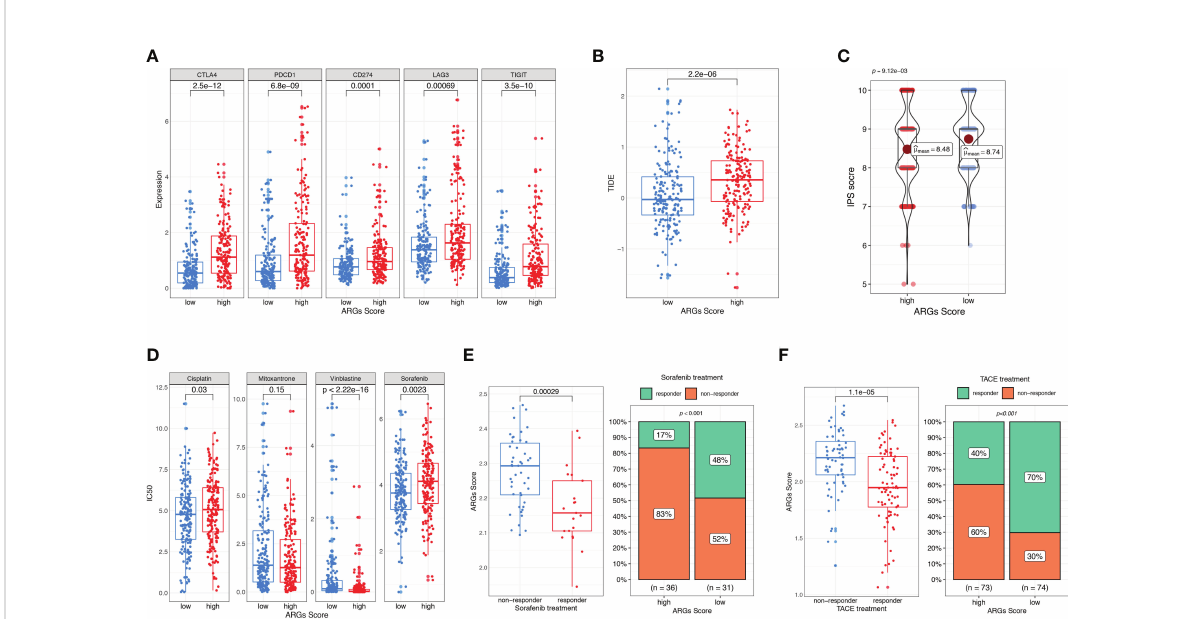
FIGURE 10 Evaluation of therapeutic response and drug sensitivity based on the ARGs Scoring model. (A) The correlation between ARGs Score and immune checkpoints genes. Difference in TIDE (B) and IPS (C) between the high-score and low-score groups. (D) Drug sensitivity analysis. IC50 of different drugs were compared between high-score and low-score groups. (E) Comparison of ARGs Score between sorafenib responder and non-responder. The fraction of sorafenib responder between subgroups based on ARGs Score classi fi er. (F) Comparison of ARGs Score between TACE responder and non-responder. The fraction of TACE responder between subgroups based on ARGs Score classi fi